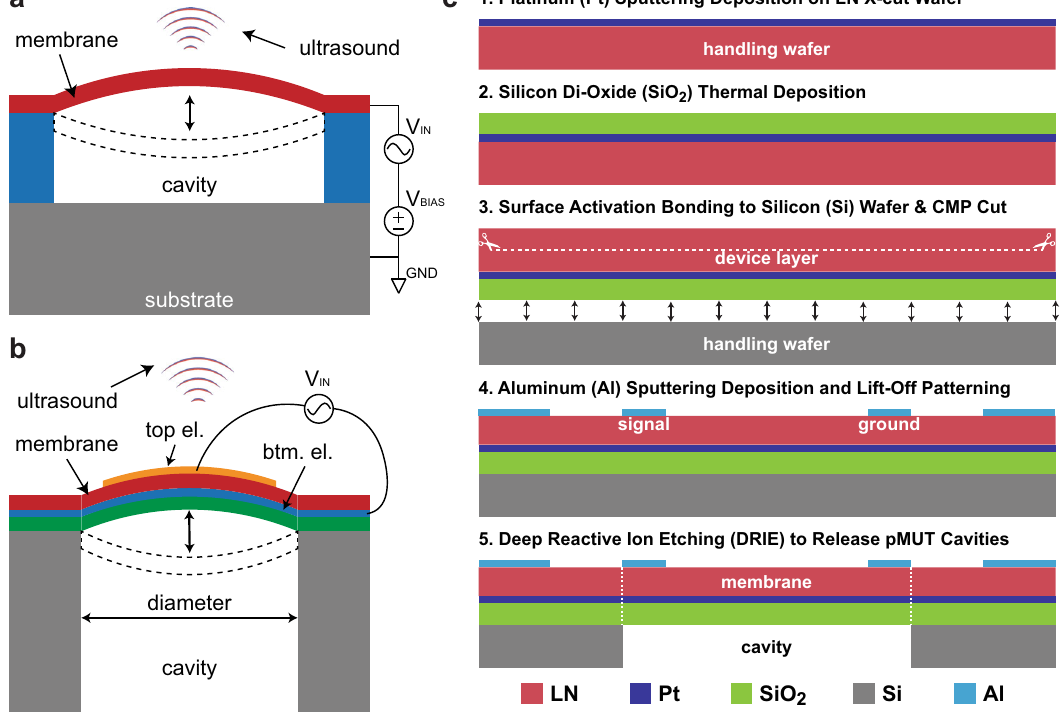
Fig. 5 MUT categories and fabrication of LN pMUTs. a Working principle of a cMUT and the main composition layers. b Working principle of a pMUT and the main composition layers. c Step-by-step fabrication process of the LN